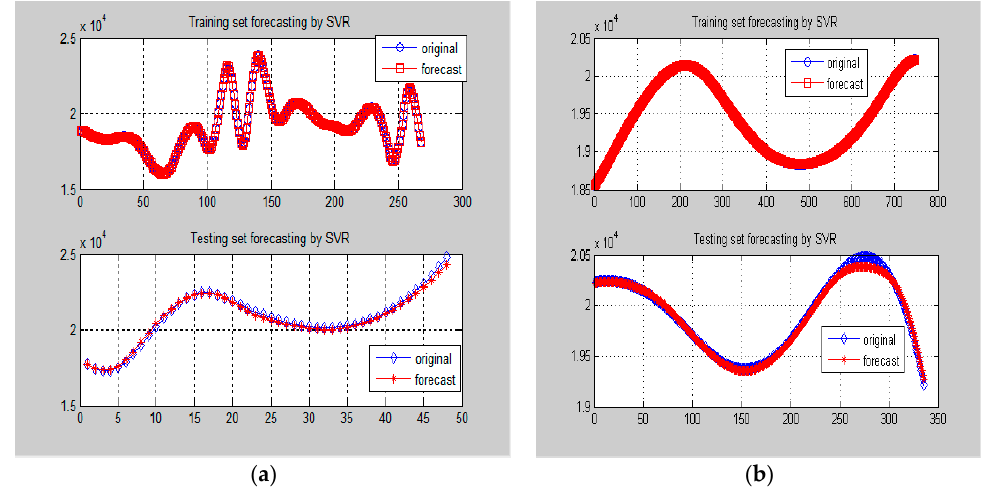
Figure 12. Comparison of forecasting results by SVR-GA model for Data-II (Example 2). ( a ) One-day ahead forecasting from 13 to 14 January 2015; ( b ) One-week ahead forecasting from 2 to 15 February 2015. Table 6. The SVR-GA’s parameters for Data-II (Example 2).